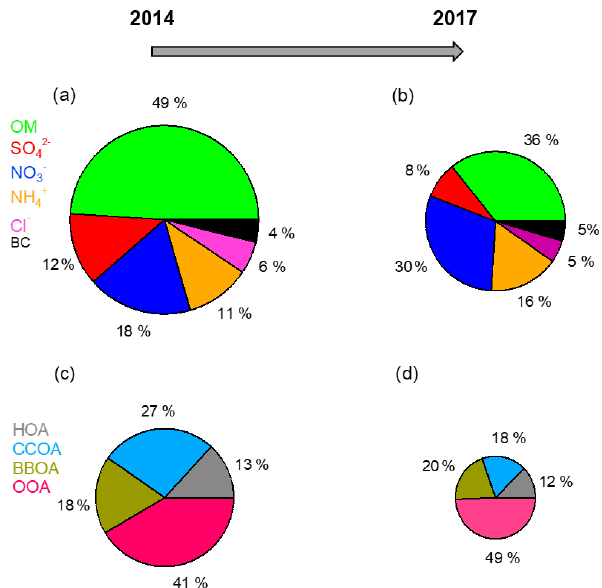
Figure 1. Average chemical compositions of PM 1 and OA in (a, c) winter of 2014 and (b, d) winter of 2017. The decreases in the mass concentrations of different components from 2014 to 2017 are as follows: 60.9% for organics, 64.1% for sulfate, 11.6% for ni- trate, 21.7% for ammonium, 50.0% for chloride, and 37.5% for